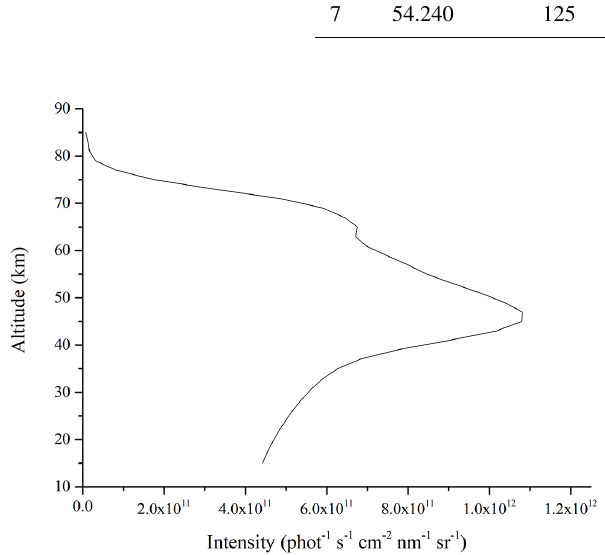
Figure 14. OH fluorescence emission radiance spectrum extracted from observed